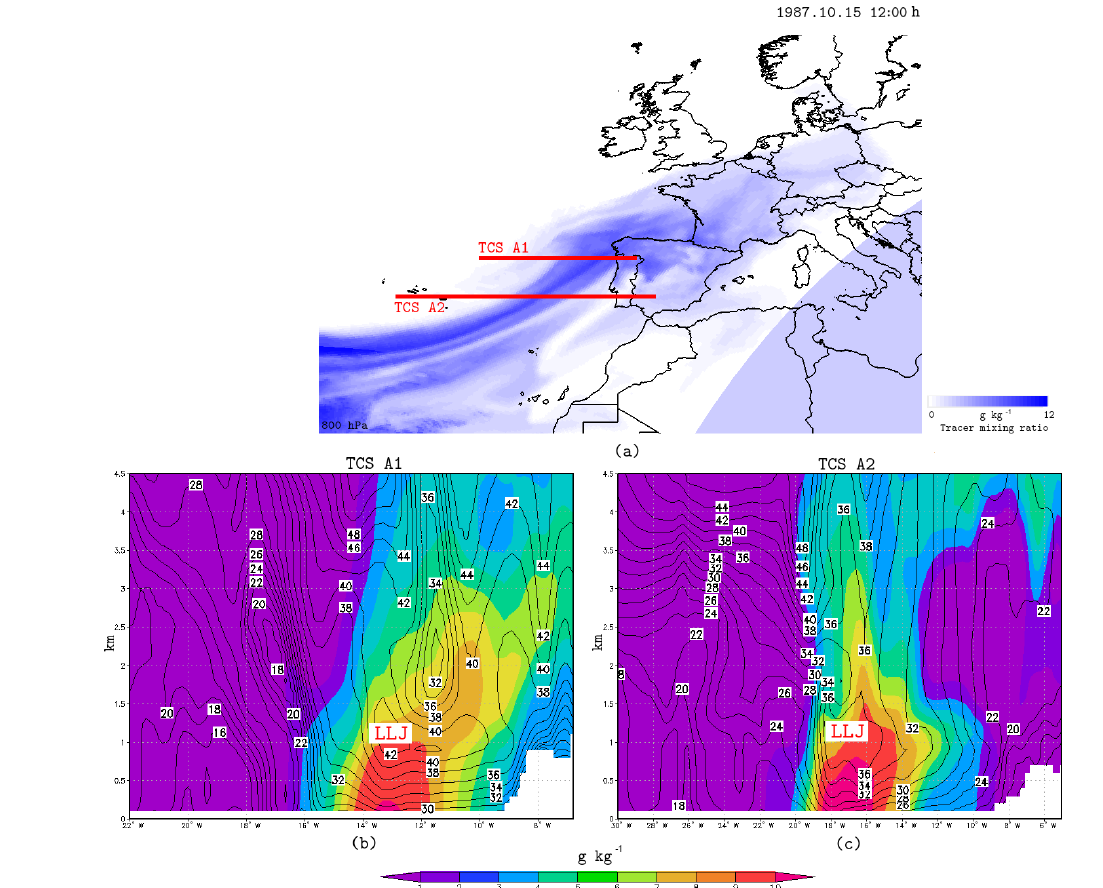
Figure A3. Same as Fig. 8 but for the Atlantic case. The corresponding latitudes are 41.8 ◦ for transversal cross section A1 and 38.0 ◦ for transversal cross section